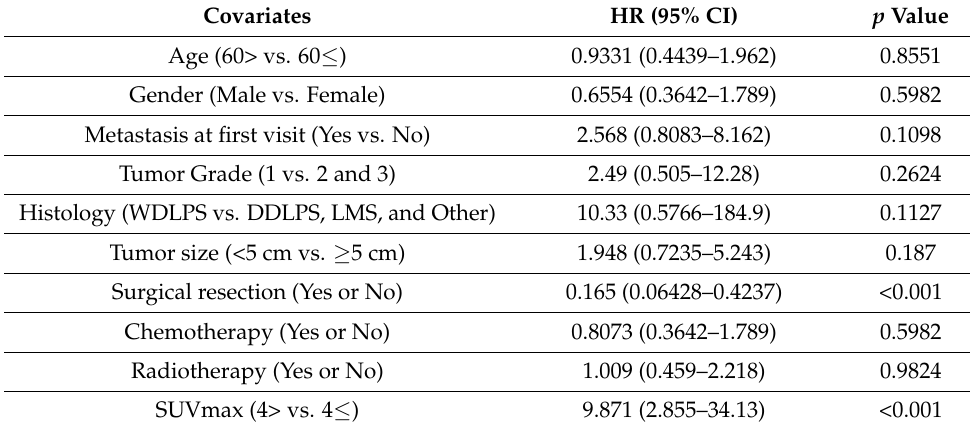
Table 4. Risk factor for OS in all RPS patients.